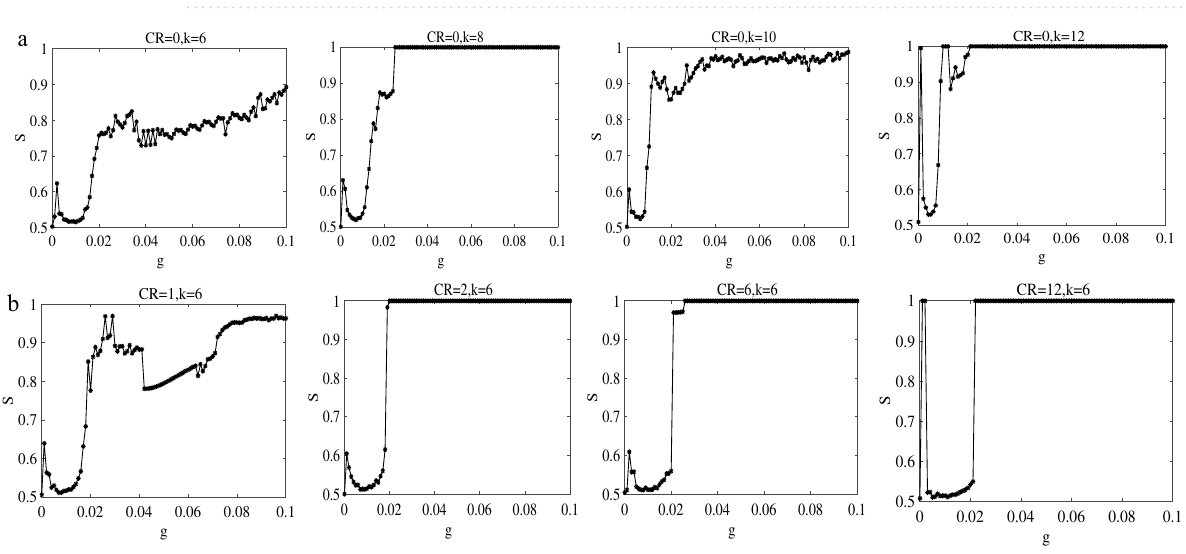
Figure 5. The ring-shaped regular network with random long-range connections. ( a )–( b ) Each neuron randomly adds 1 long-range connection during sleep and wake. ( c )–( d ) Each neuron randomly adds 10 long- range connections during sleep and